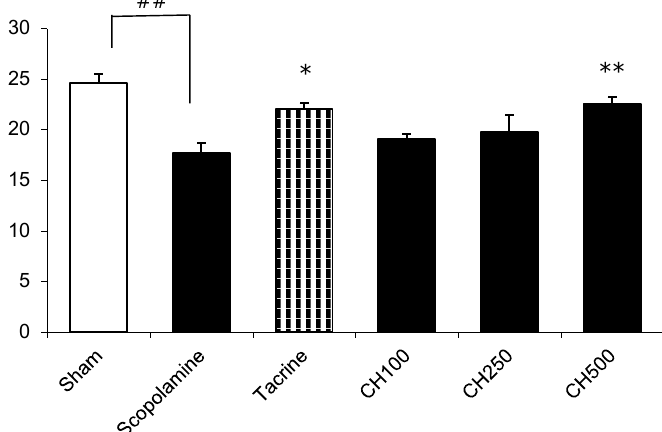
Figure 4. Inhibitory effects of tacrine (at a dose of 10 mg/kg/day) and root-bark extract of CH (at doses of 100 (CH100), 250 (CH250) and 500 (CH500) mg/kg/day on scopolamine-induced-memory impairment according to the water-maze test. The data are represented as means ± SEMs ( n = 10). One-way ANOVA and Turkey’s post hoc analyses were used for determination of statistical significance. ## p < 0.01, a significant difference compared with the controls; * p < 0.05 and ** p < 0.01, a significant difference compared with the scopolamine-treated mice.